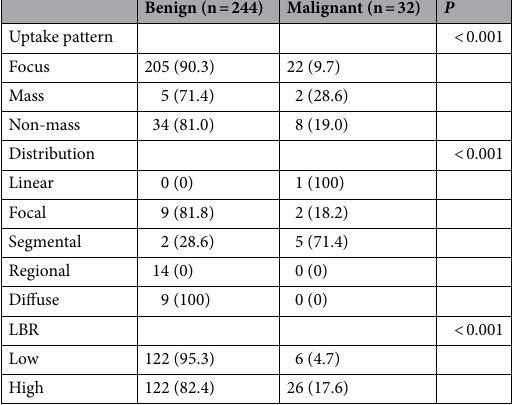
Table 2. Frequency of malignancy according to uptake patterns and LBR on dedicated breast PET. IQR, interquartile range; LBR, lesion-to-background ratio.